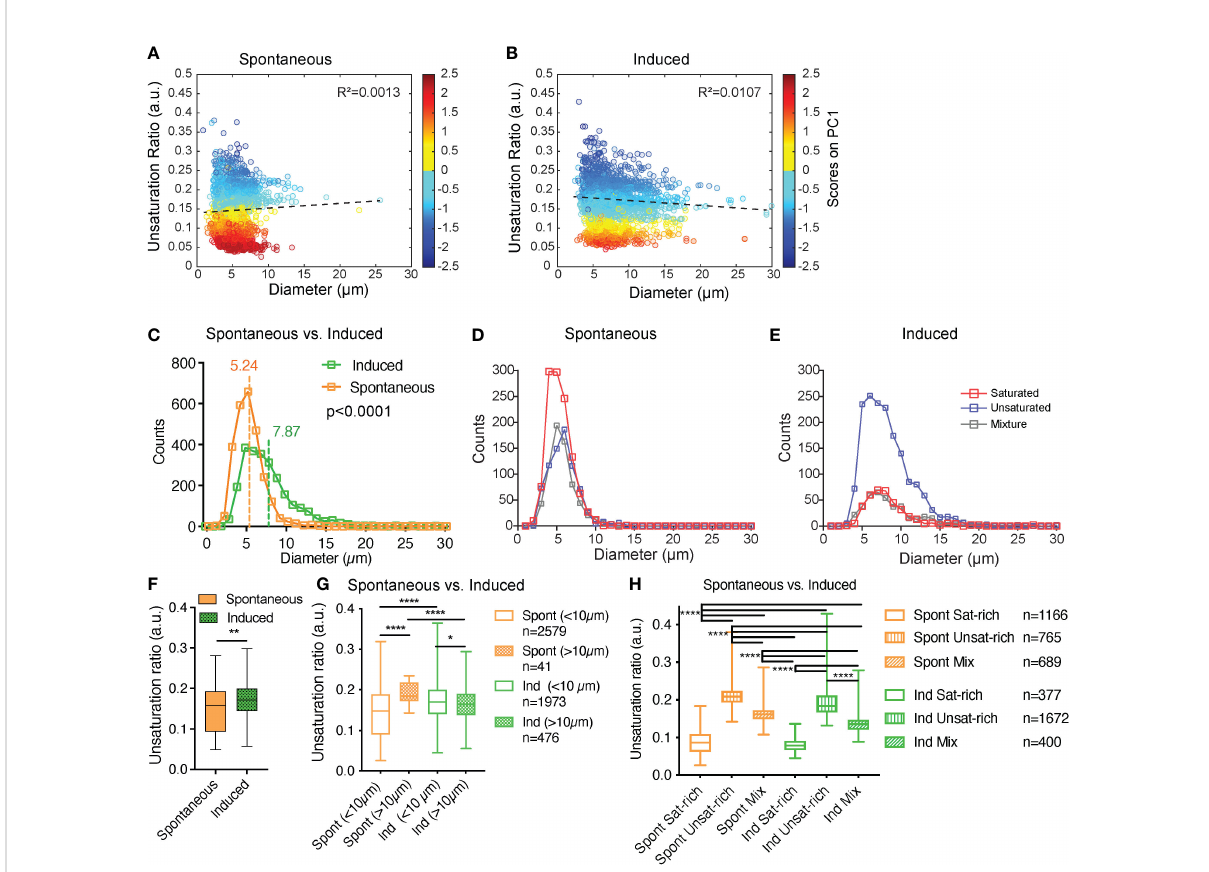
FIGURE 5 Induced adipocytes are composed of larger lipid droplets than spontaneous adipocytes, but there is no overall correlation between lipid droplet diameter and unsaturation ratio. (A, B) Unsaturation ratio as a function of the diameter of the LDs for sOP9 versus iOP9 adipocytes (n = 3 independent experiments, pooled for LD analysis). The low R2 for both conditions indicates that the diameter of the LDs is not correlated with the unsaturation ratio. Dashed lines represent the correlation line. The Y axis is colored as function of the score of PC1. The circles in dark blue corresponds to LDs identi fi ed as unsaturated rich. The circles in dark red correspond to LDs identi fi ed as saturated-rich. The circles in yellow and light blue correspond to LDs identi fi ed as mixture. (C) Histogram for frequency of LDs as a function of the diameter for the spontaneous and induced condition. Vertical lines show the mean diameter of the LD for each condition. The mean diameter of LDs is 5.24µm (±1.85µm) and 7.87 µm (±3.83µm) for sOP9 adipocytes and iOP9 adipocytes, respectively. The LDs mean diameter of sOP9-adipocytes is signi fi cantly lower compared to iOP9-adipocytes (P < 0.0001, Mann-Whitney test). (D, E) When separated according to LD type a trend toward larger unsaturated lipid droplets in the induced condition is observed. (F) Unsaturation ratios of sOP9 versus iOP9 at LD level. LDs from iOP9 adipocytes have a higher mean unsaturation ratio compared to LDs from sOP9 adipocytes. (P < 0.0014, Mann-Whitney test). (G) At single droplet resolution, larger droplets (>10µm) have a higher unsaturation ratio as compared to smaller lipid droplets, while smaller droplets (<10µm) in induced OP9- adipocytes (n = 1973) have a higher unsaturation ratio than those of spontaneous OP9-adipocytes (n = 2579). Highest unsaturation ratio overall is seen in large droplets from spontaneous OP9-adipocytes (n = 41). (H) Unsaturation ratio as a function of the condition (spontaneous